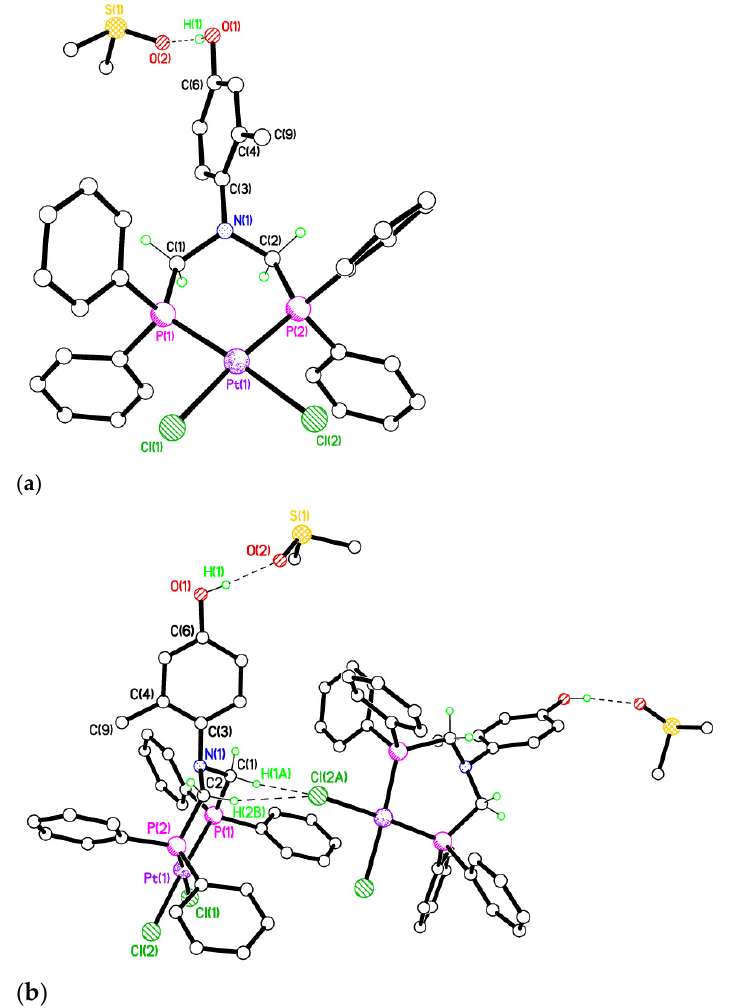
Figure 9. ( a ) Crystal structure of 4b ∙ (CH 3 ) 2 SO showing the hydroxyl group H-bonding to the DMSO molecule of crystallisation. Most H-atoms removed for clarity. ( b ) Packing interactions in the crystal structure of 4b ∙ (CH 3 ) 2 SO. Most H atoms omitted for clarity. Symmetry operator A = y − 1, 1 − x, ¼ + z.